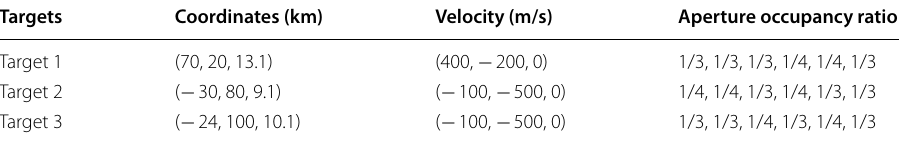
Table 1 Characteristics of the targets in scenario 1